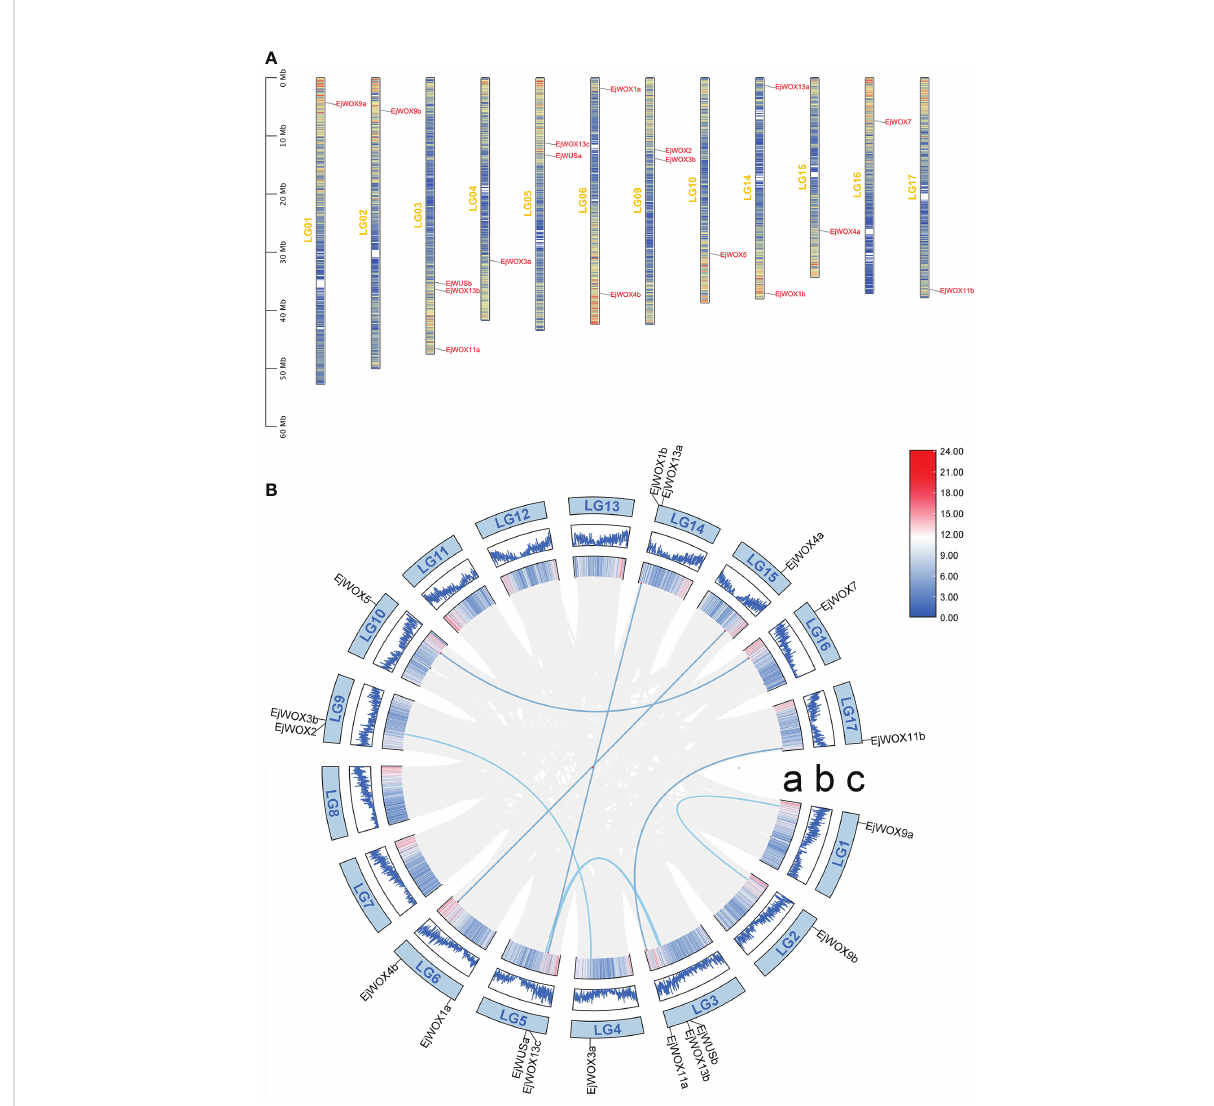
FIGURE 3 Chromosomal localization and synteny analysis of the EjWOX genes. (A) The chromosomal localization of the EjWOX genes. The chromosome numbers are marked on the left of each chromosome. Gene names are marked to the right of each chromosome. The black line with the scale on the left represents the length of the chromosomes. The colored lines within these columns represent gene density. (B) The synteny analysis of the EjWOX genes. Syntenic gene pairs are connected by blue lines. a: The colored lines indicate gene density. b: The width of the blue lines represents the gene density. c: LG01-LG17 represent 17 loquat